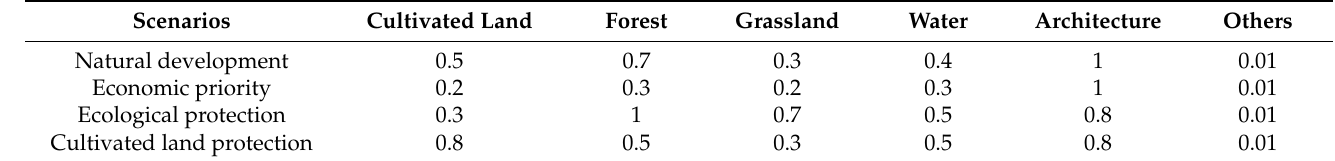
Table 4. Neighborhood factor